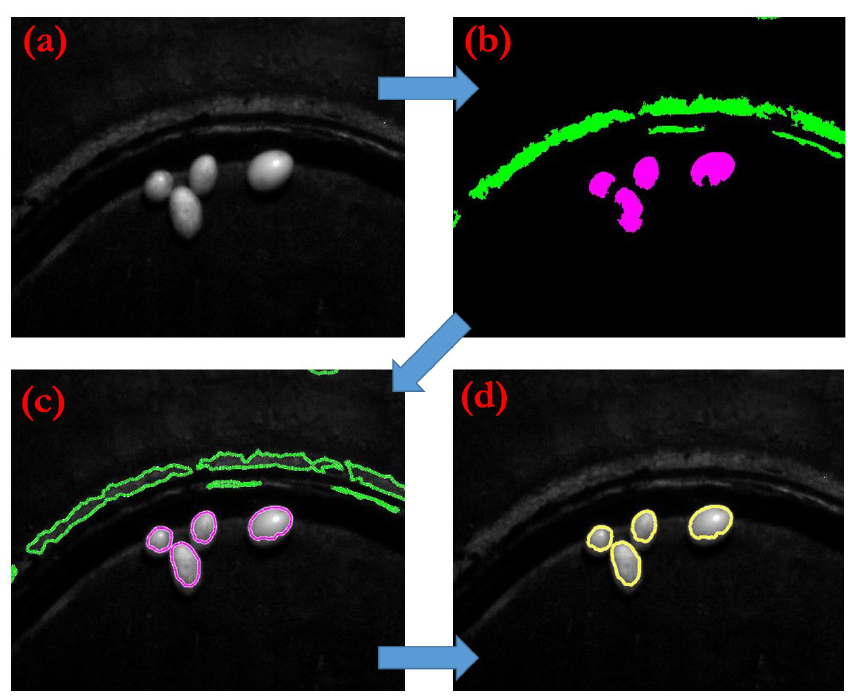
Figure 4. Detection of the contour of the olives. ( a ) Infrared image. ( b ) Global mask (magenta) and adaptive mask (green). ( c ) Active contours obtained with each mask. ( d ) Final active contours.